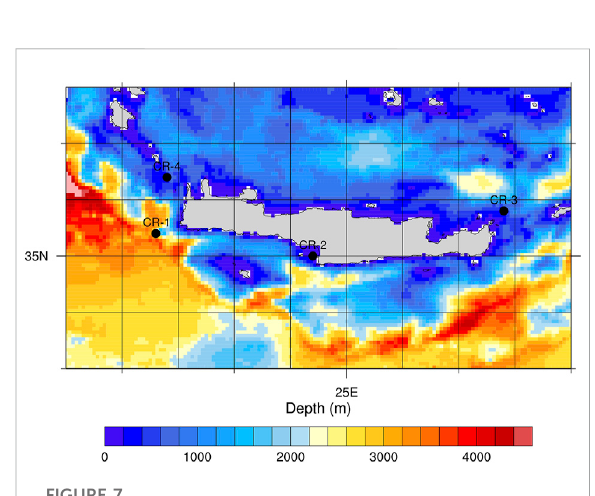
FIGURE 7 WavemodelbathymetryfortheareaaroundCrete.Locations used for the speci fi c analysis are also